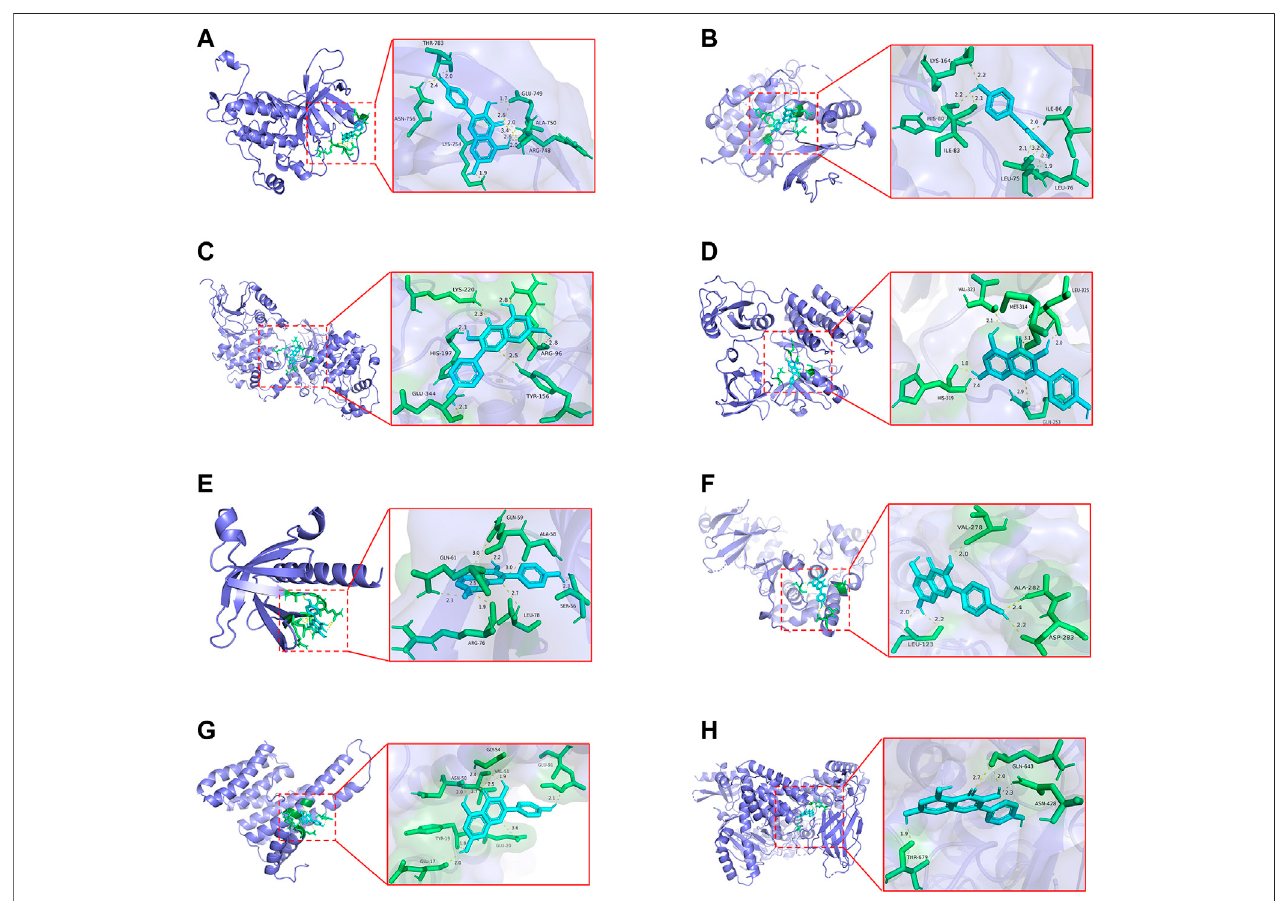
FIGURE10| Thedockingmodelsofkaempferolwiththeidenti fi edthetopeightcriticaltargets. (A) Dockingresultsofkaempferoland EGFR. (B) Dockingresultsof kaempferol and MAPK1. (C) Docking results of kaempferol and MAPK3. (D) Docking results of kaempferol and SRC. (E) Docking results of kaempferol and AKT1. (F) Docking results of kaempferol and MAPK8. (G) Docking results of kaempferol and RELA. (H) Docking results of kaempferol and PIK3CA.